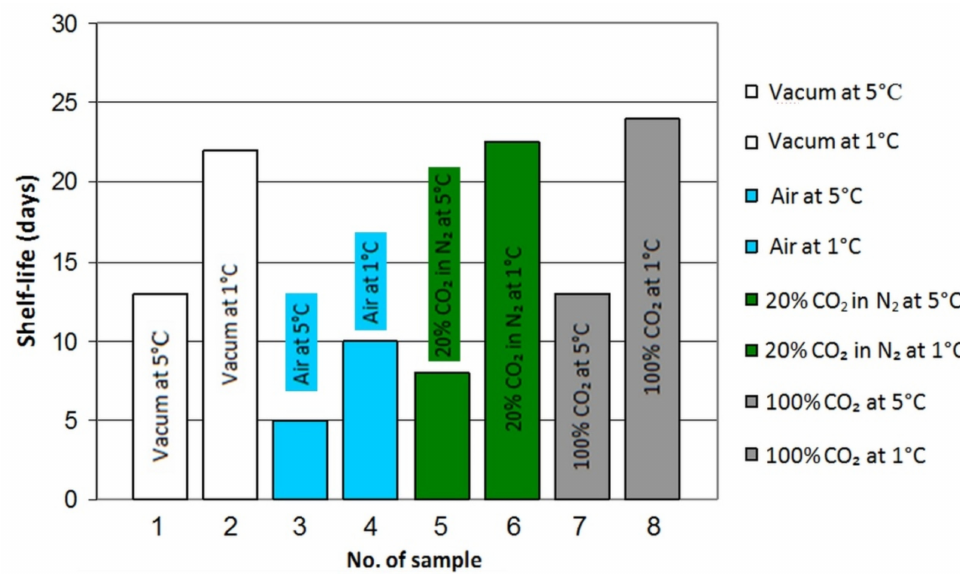
Figure 3. Chicken’s meat shelf-life in different temperature and gas mix combinations, reprinted with permission from WITT